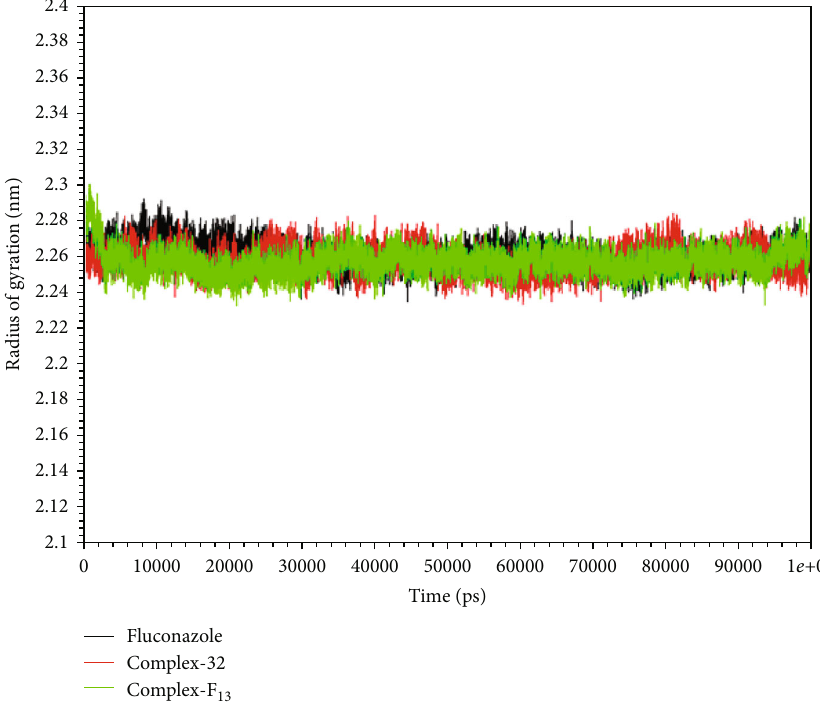
Figure 11: Radius of gyration curve during 100 ns simulation ( fl uconazole: protein- fl uconazole complex, complex-32: protein-ligand complex, complex-F13: protein'-ligand complex).